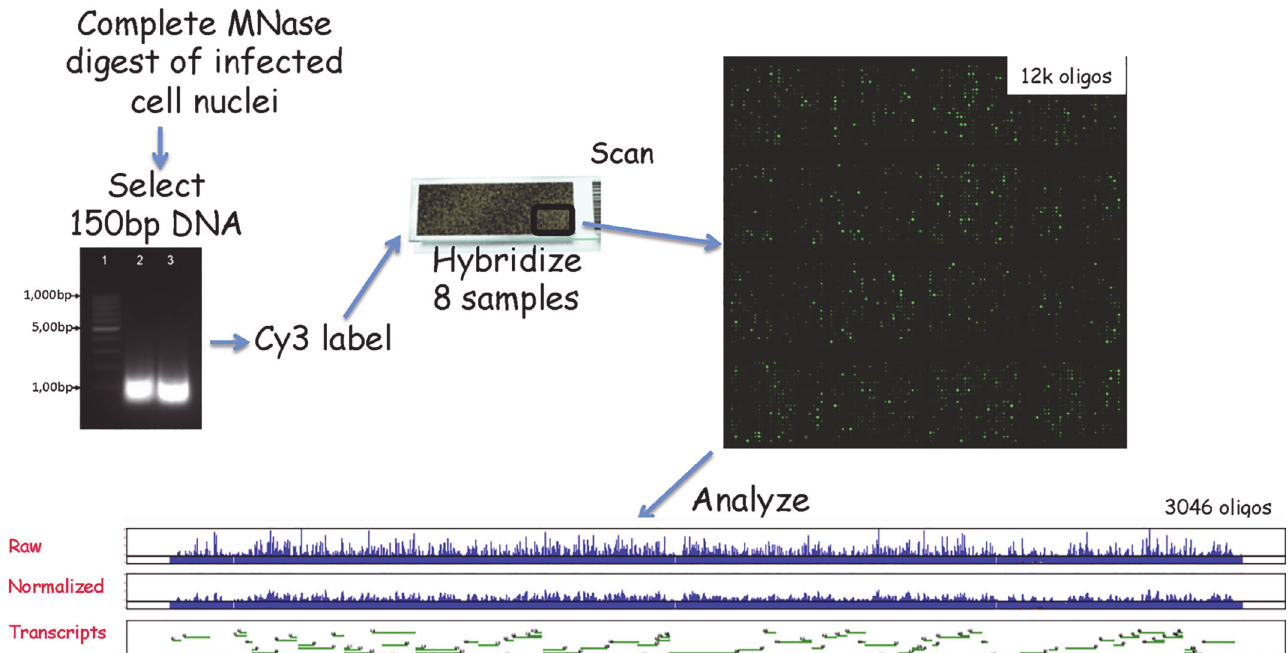
Fig 1. Array Design and Nucleosome Counting. SY5Y cells were infected with HSV-1 at a moi of 5. At 6h post infection cells were harvested and nuclei prepared. Nuclei were digested to completion with MNase and the DNA fragments purified. These were separated by gel electrophoresis and the 150bp band eluted and labeled with Cy3. The array slide consisted of 8 wells containing approximately 12k x 50mer oligonucleotides. The 50mers covered the entire HSV-1 genome and were tilled with a 25nt overlap. In each well there were 3 sets of 3046 oligos covering the HSV genome plus some alien (control) oligos. Eight labeled samples were hybridized on the array slide and subsequently analyzed for the position of nucleosomes on the HSV genome as described in the